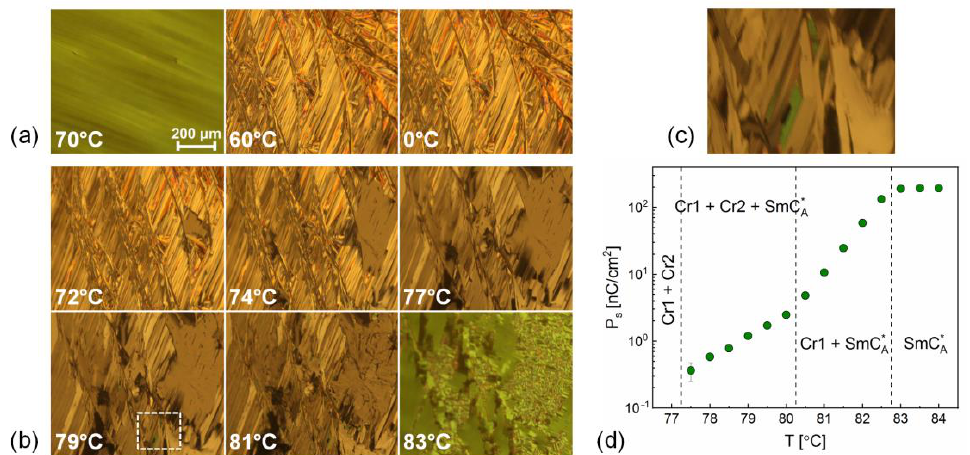
Figure 12. Textures of 4FF in an external electric field registered on cooling ( a ) and heating ( b ), enlarged part of the texture registered at 79 °C on heating showing the small domains of the SmC A∗ phase ( c ) and spontaneous polarization vs. temperature on heating in the vicinity of the melting of a crystal phase (d).